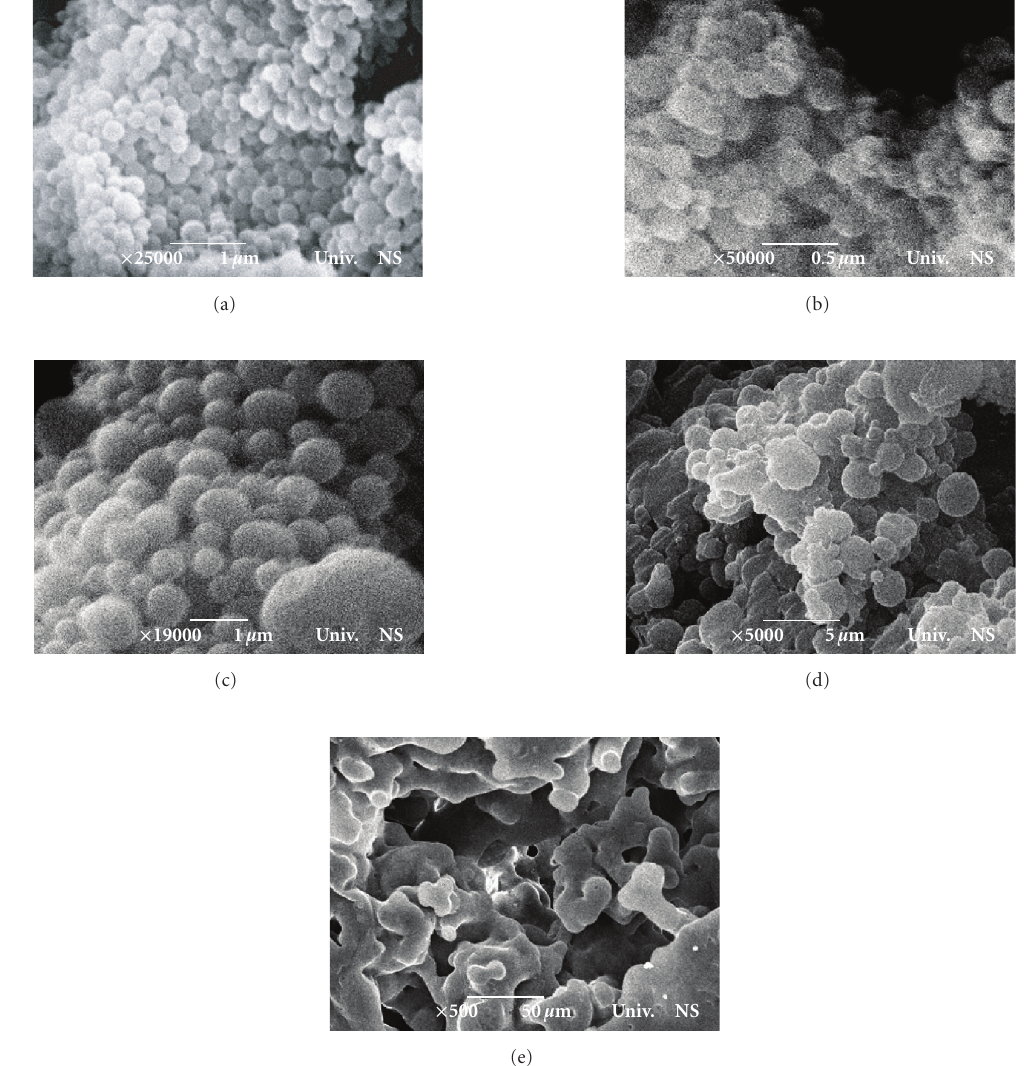
Figure 5: SEM images of (a) DLPLG nanoparticles; (b) DLPLG/ascorbic acid 85/15% nanospheres; (c) DLPLG/ascorbic acid 70/30%; (d) DLPLG/ascorbic acid 50/50%; (e) DLPLG/ascorbic acid 30/70%.